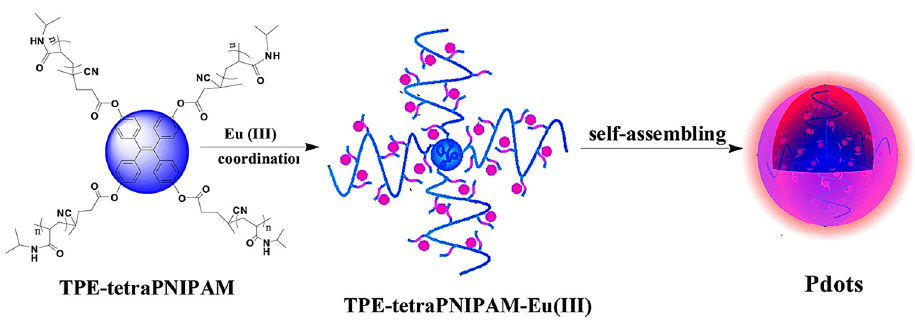
Figure 15. The molecular structure of AIE active Pdots TPE-tetraPNIPAM-Eu (III) used for imaging of cancer cells.